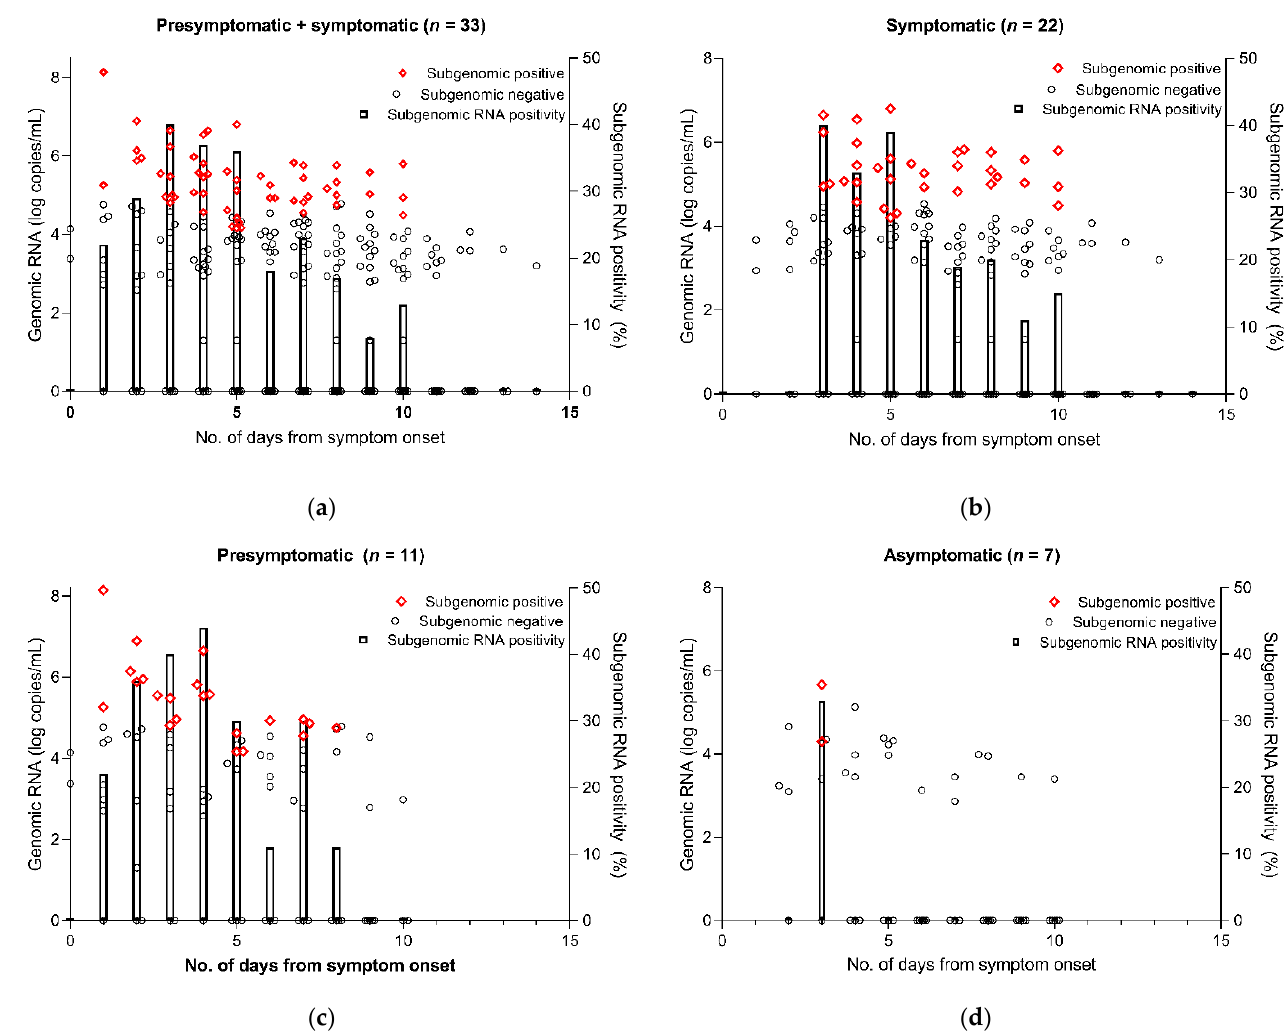
Figure 3. Results of subgenomic RNA test for SARS-CoV-2. The subgenomic positive (red) is plotted as the genomic copy number in a sample (left y -axis), where subgenomic RNA was also detected. The subgenomic negative (black) is plotted as the genomic copy number in a sample (left y -axis), where no subgenomic RNA was detected. The subgenomic positivity (right y -axis) indicates the percentage of subgenomic RNA-positive samples among the total samples by the day. ( a ) Presymptomatic + symptomatic. ( b ) Symptomatic. ( c ) Presymptomatic. ( d ) Asymptomatic.